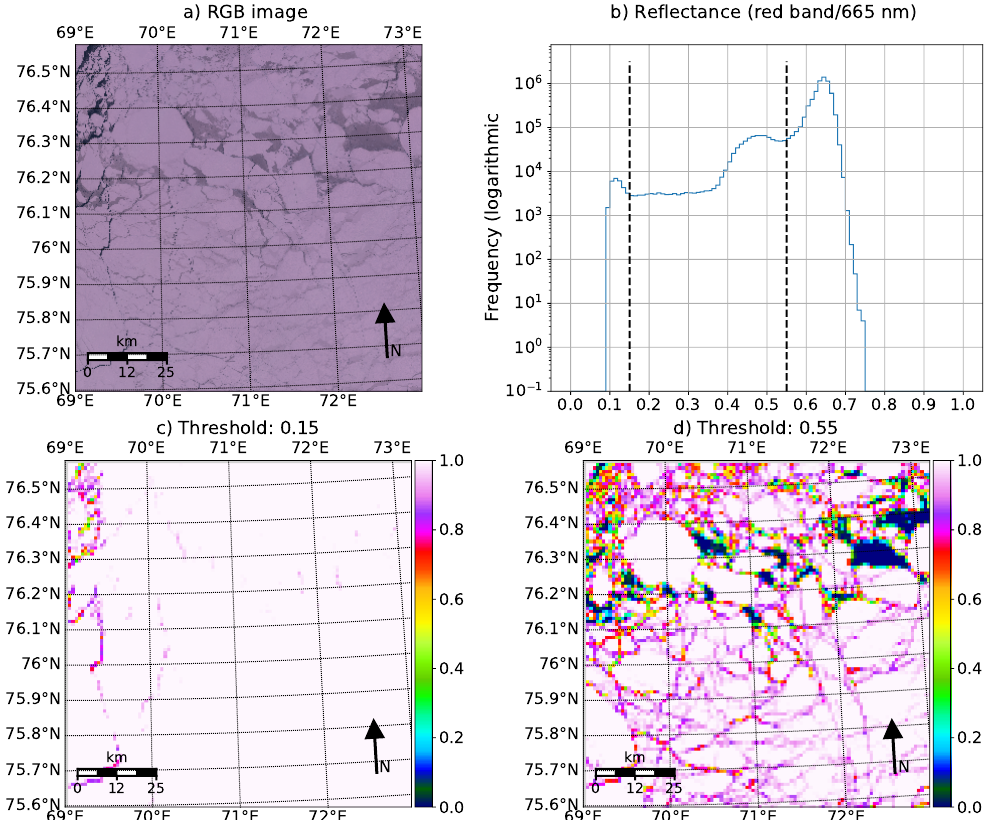
Figure 6. Sentinel-2 SIC in the Kara Sea on 12 March 2019. ( a ) RGB image showing open water, thin ice and thicker ice. ( b ) Frequency distribution of the 665 nm reflectance. Mind the logarithmic scaling of the y axis. Vertical dashed lines mark the threshold for the thin and thick-ice class. ( c ) Sentinel-2 SIC if thin ice is treated as ice. ( d ) Sentinel-2 SIC if thin ice is treated as water.